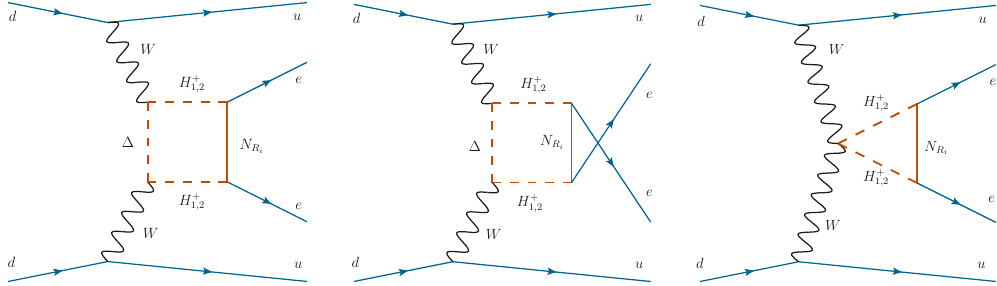
SD for the Class 2 model from 0 (cid:23)(cid:12)(cid:12) A